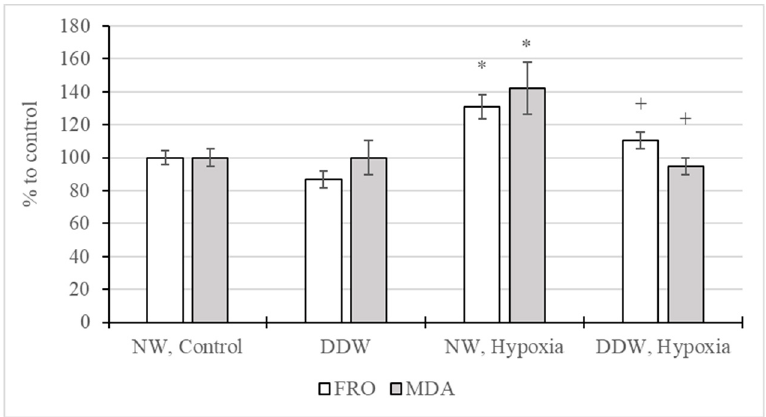
Figure 2. The intensity of free radical oxidation (FRO) and the content of malondialdehyde (MDA) in the brains of rats consuming normal water (NW) and deuterium-depleted water (DDW) under exposure to hypoxia (M ± m). *— p < 0.05 in comparison with control, +— p < 0.05 in comparison with “NW, Hypoxia”.